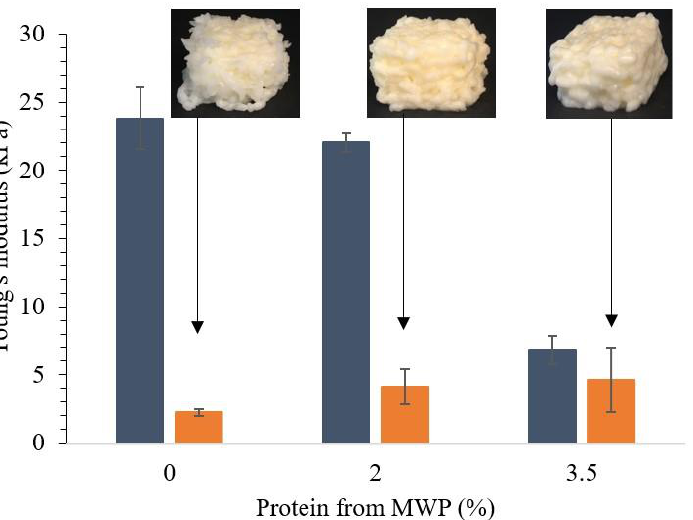
Figure 3. WPI and microparticulated whey protein (MWP) emulsion gels (10% fat w/w ) with a total protein content of 10%. Emulsion gels formed with 0, 2, and 3.5% protein from MWP and 10, 8, and 6.5% protein from WPI, respectively, before and after 3D printing. Shown are averages of triplicate measurement and error bars as std. deviations.